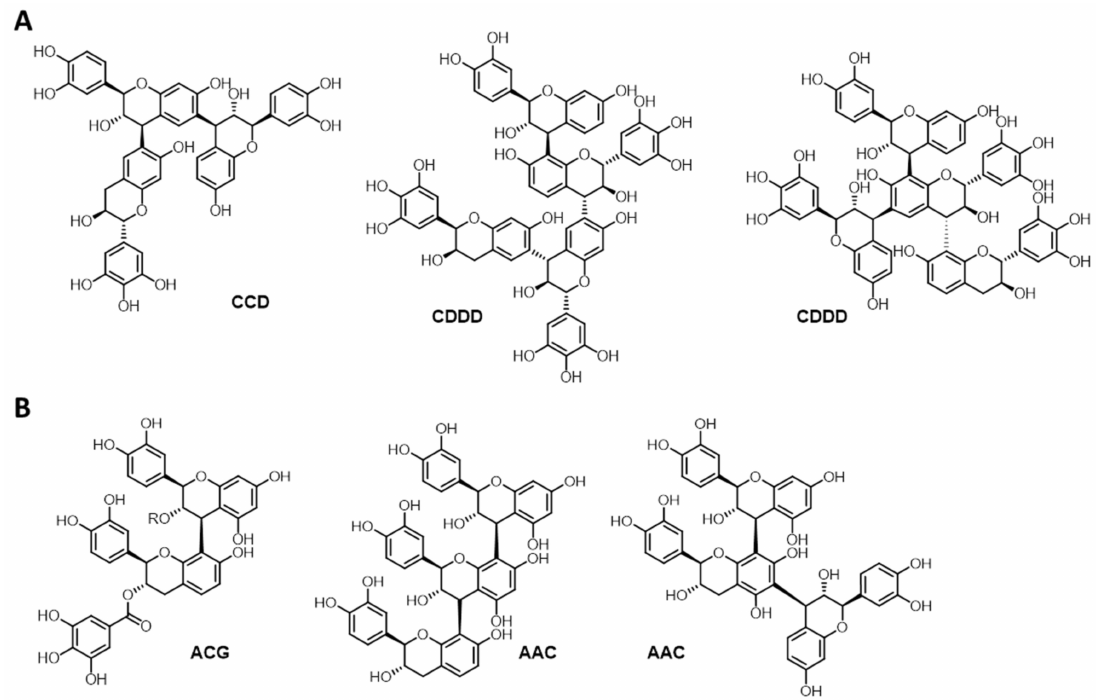
Figure 4. Structural representations delineated on the basis of NMR and MALDI-ToF data of ( A ) MIMOSA ATO ME ( Am ) and ( B ) QUEBRACHO ATO ( Sb